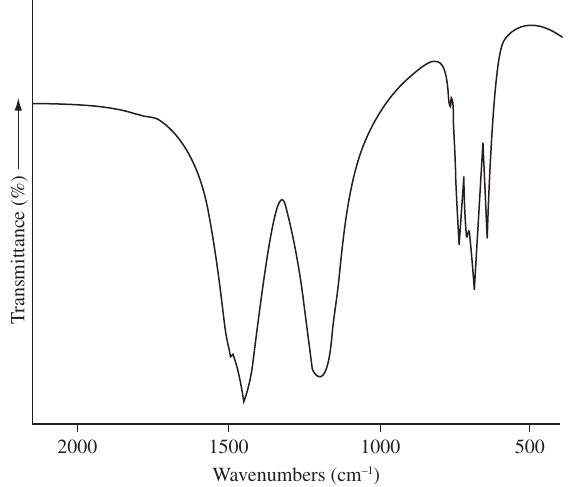
Figure 2. FTIR spectrum of one of the prepared CaB spectral range between 2000-400 cm –1